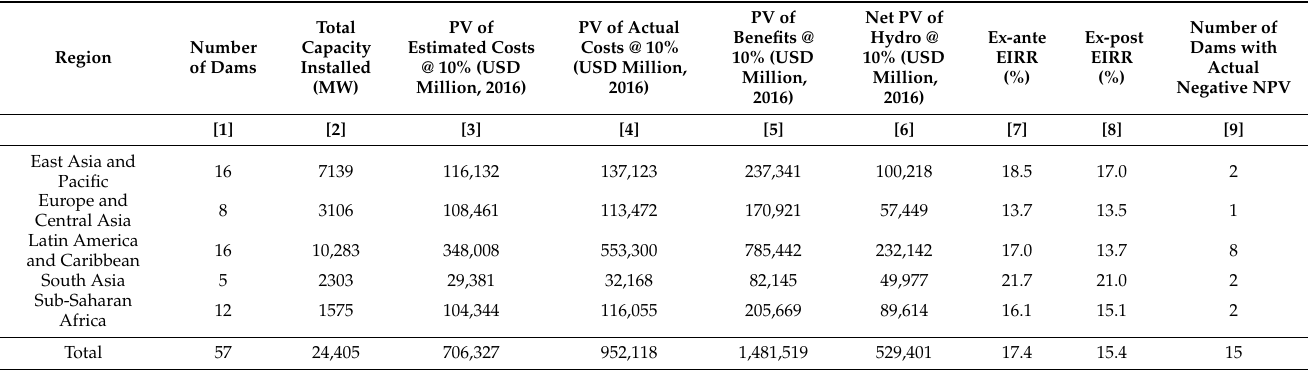
Table 11. Estimated vs. actual EIRR by